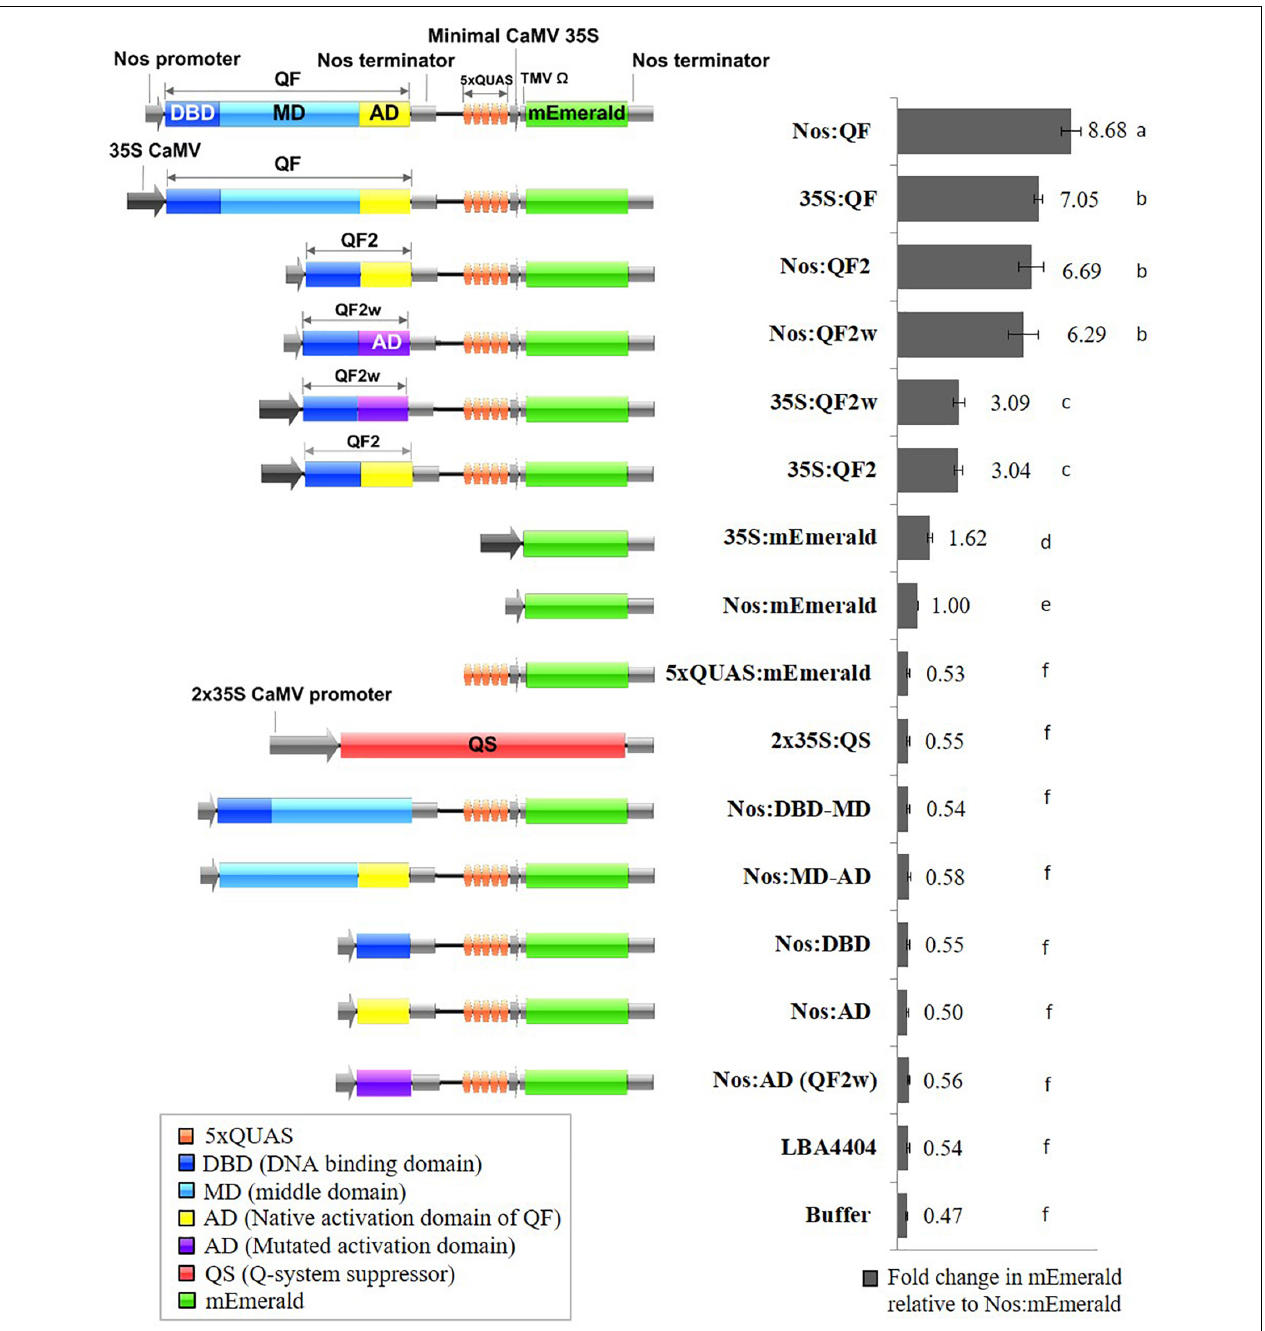
FIGURE 2 | Schematic representation of Q-system constructs and the fold change in mEmerald fluorescence relative to Nos:mEmerald. Spectrofluorescence readings taken at 509 nm, 72 h post Agrobacterium infiltration of N. benthamiana leaves. Statistical significant differences determined using one-way ANOVA with post hoc analysis using Tukey HSD: groups with different letters show a significant difference ( p < 0.05). Data represent mean ± standard error of three independent experiments ( n = 3). Three technical replicates were collected for each biological replicate to account for positional